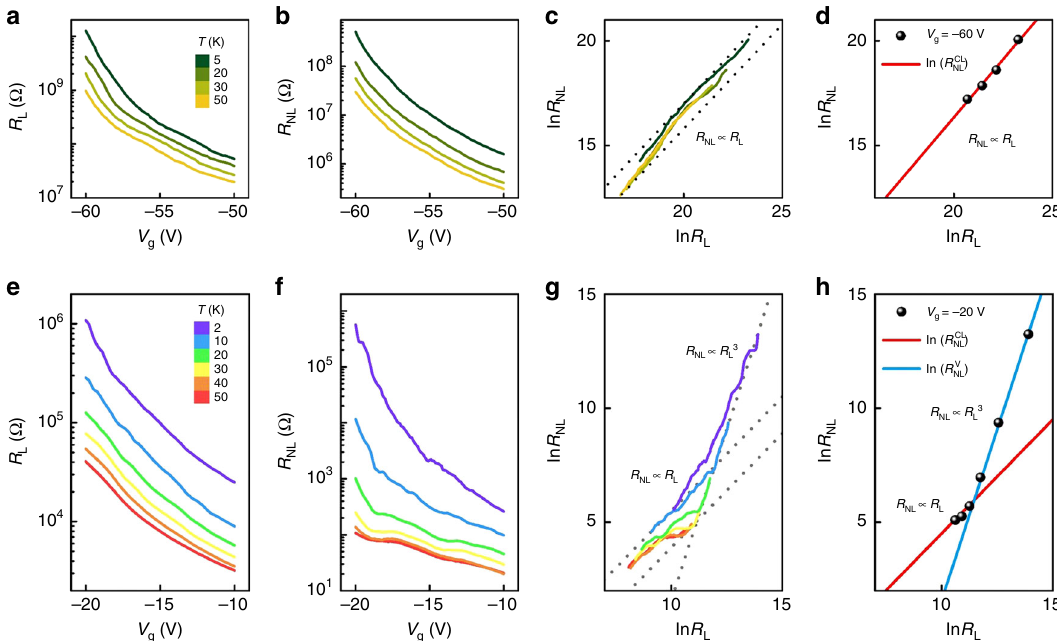
Fig. 3 Local and nonlocal resistances of bilayer and trilayer MoS 2 . a , b , e , f Gate-dependence of R L and R NL at different temperatures in bilayer a , b and trilayer e , f samples. c , g Scaling relation between ln R L and ln R NL is obtained at different temperatures in bilayer c and trilayer g samples. For the trilayer case, R NL scales linearly with R L in the high electron density regime, whereas the cubic scaling law R NL ∝ R L 3 is observed in the low electron density regime ( n c = 4 × 10 11 cm − 2 or V g = − 18.4 V). d ln R L v.s. ln R NL for bilayer MoS 2 . In the full range of gate voltages, R NL scales linearly with R L , and the experimental data (black dots, V g = − 60 V) is fi tted by a linear curve (red solid line). h ln R L v.s. ln R NL for trilayer MoS 2 . The experimental data (black dots, V g = − 20 V) clearly show two different regimes which are fi tted by two linear curves (red solid line with slope 1 and blue solid line with slope 3). Evidently, a crossover exists from linear ( R NL ∝ R L ) to cubic scaling behaviors ( R NL ∝ R L 3 plots of R L and R NL in Fig. 3g exhibit clear changes in slop from 1 to 3 near V g = − 18.4 V, further con fi rming the observation of the